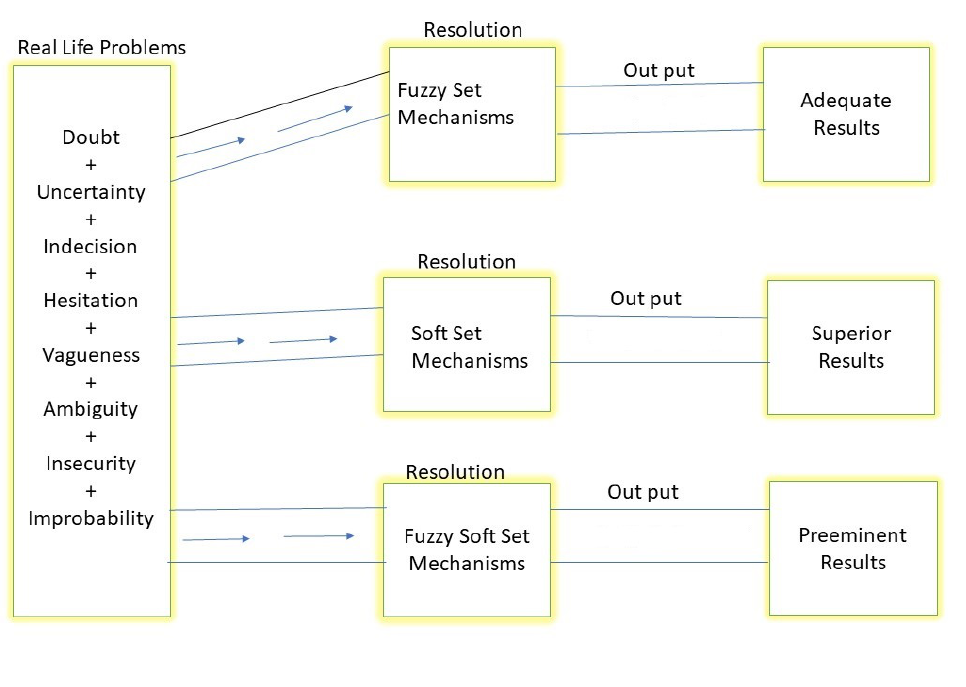
Figure 4. Decision-making